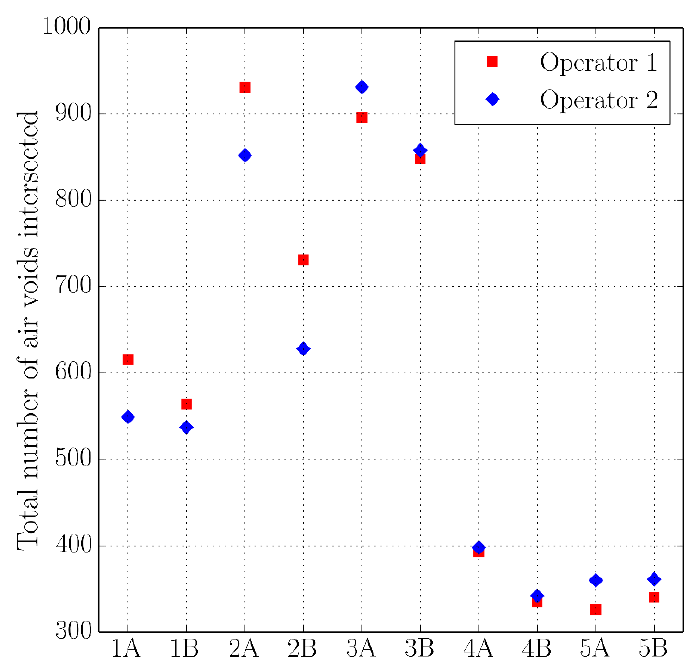
Figure 6. Results of the voids intersected of the slabs studied by two distinct operators.